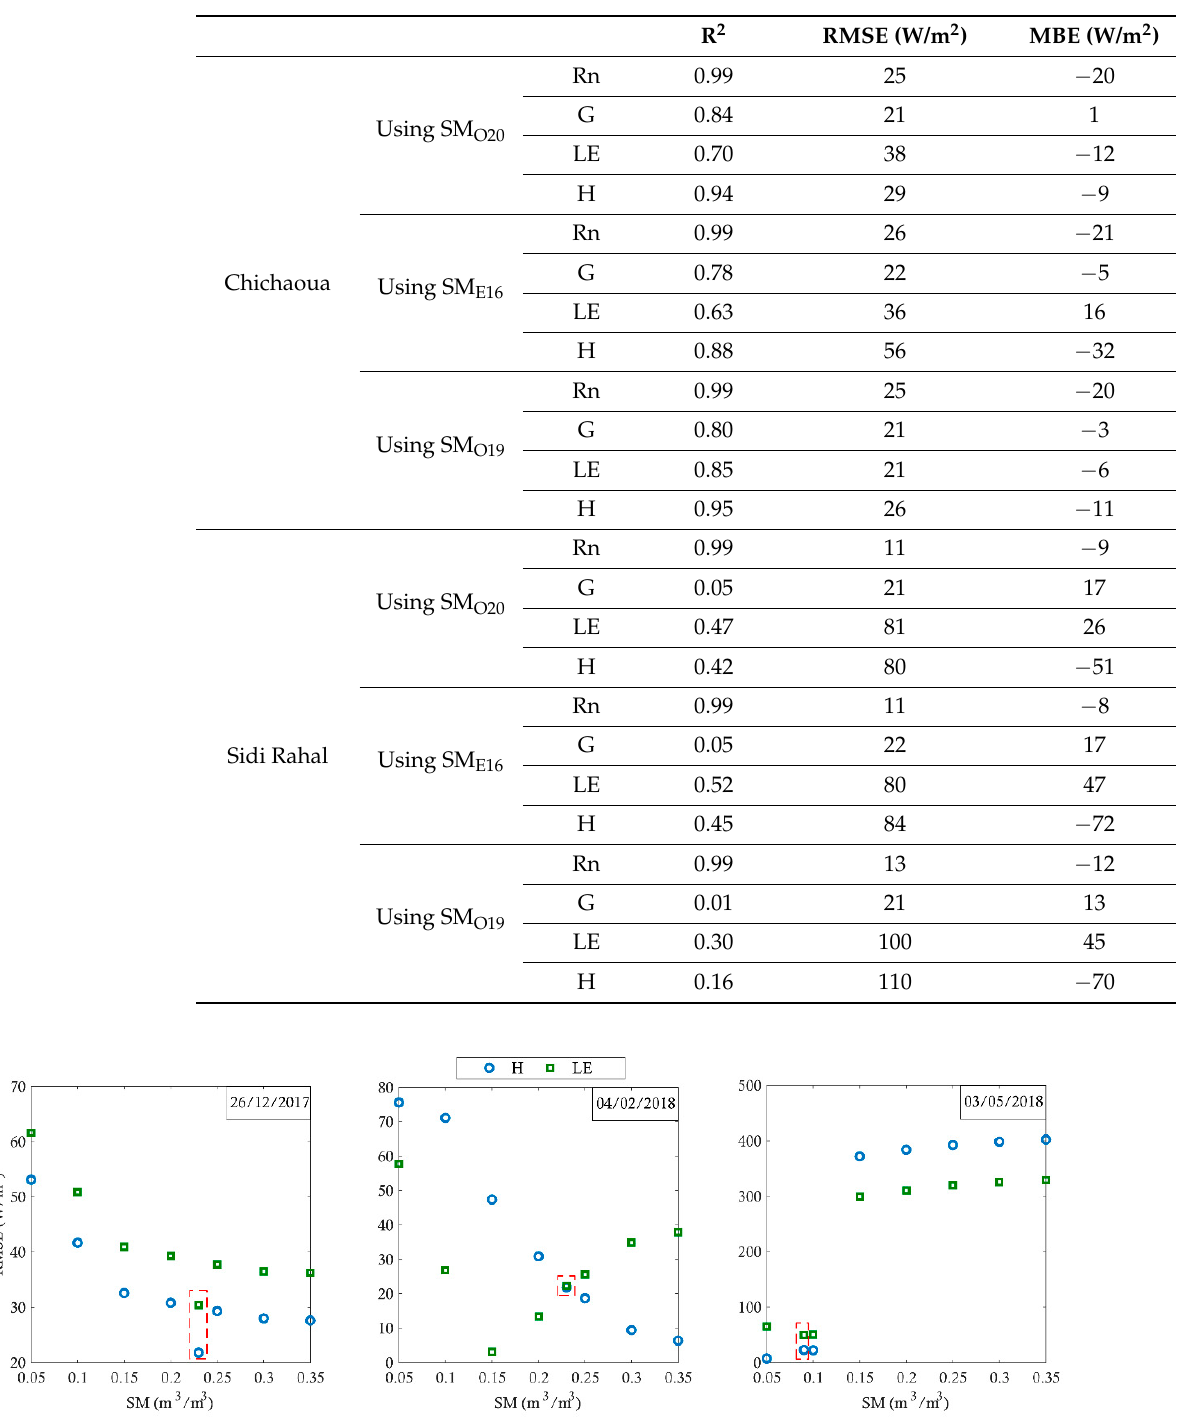
Figure 8. SM change as input to TSEB-SM vs. the H and LE RMSE over the Chichaoua site on three selected dates.